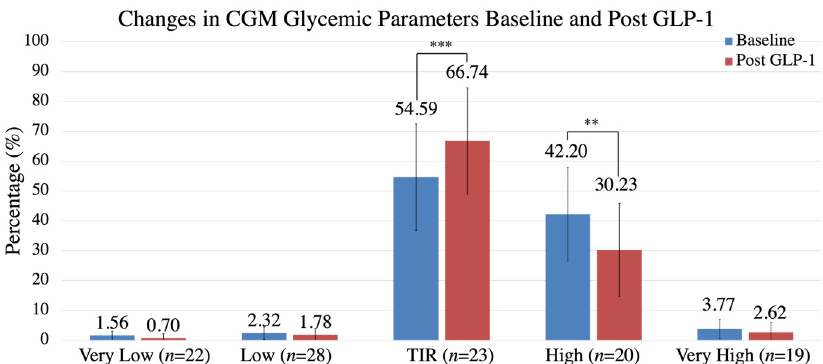
Figure 1. Changes in CGM glycemic parameters at baseline and post GLP-1. ** p < 0.01, *** p < 0.001. Average weight decreased significantly from a baseline of 86.66 ± 19.24 kg to 83.50 ± 20.83 kg, (mean difference = − 3.16 kg, p = 0.007, n = 36). There were no statistically significant differences between baseline and post-GLP-1 CGM values for serum creatinine ( p = 0.54, n = 37), total cholesterol ( p = 0.63, n = 27), LDL-Cholesterol ( p = 0.38, n = 24), systolic blood pressure ( p = 0.76, n = 19), or diastolic blood pressure ( p = 0.41, n = 19) (Table 3).